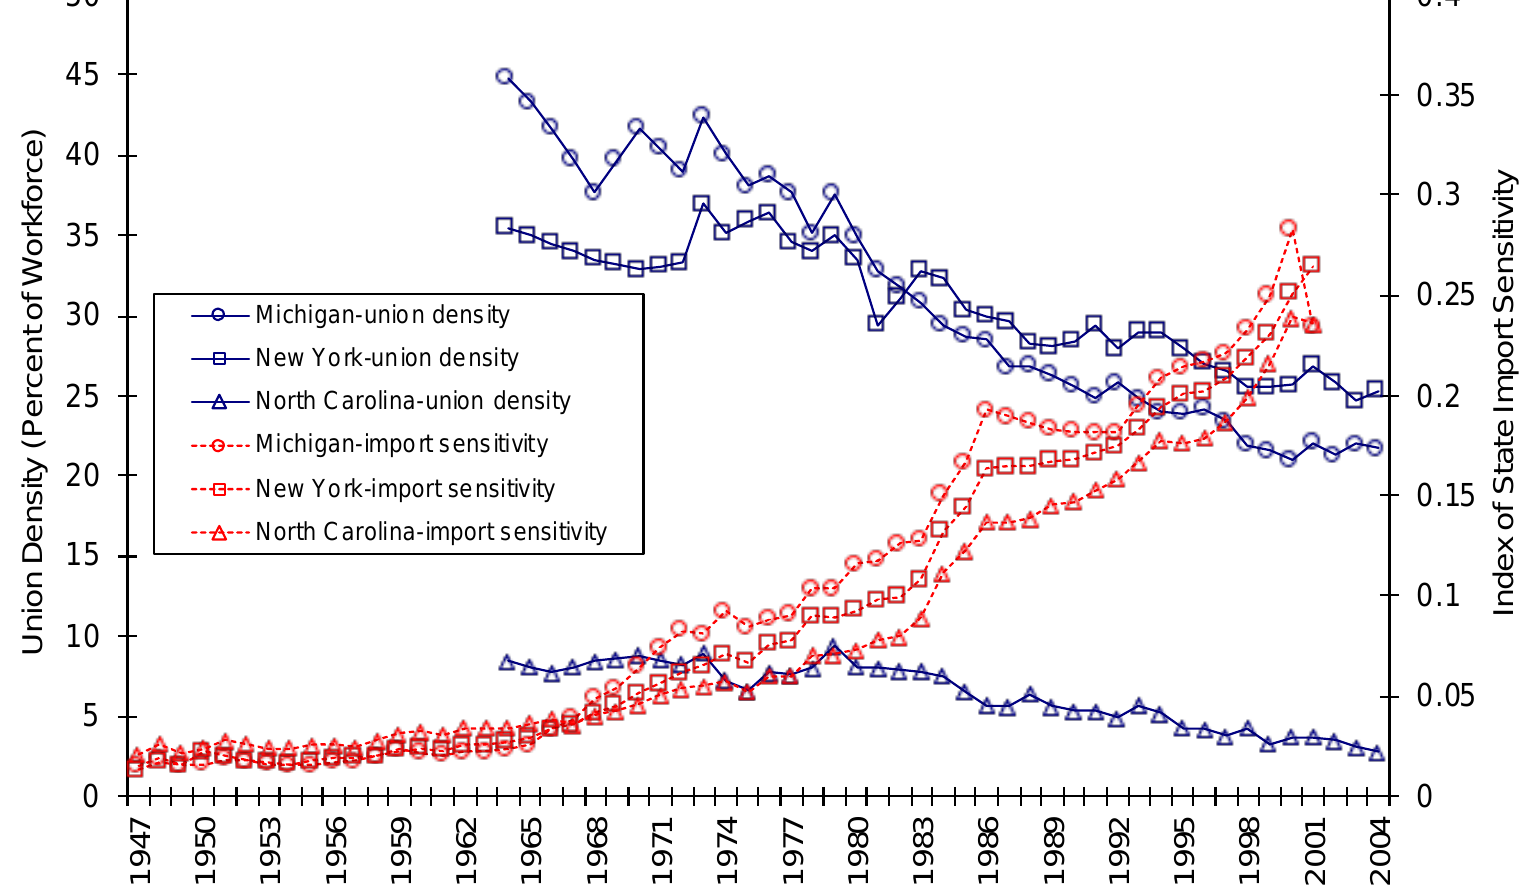
Figure 3. Union Density and Import Competition in Three States, 1947 – 2004.